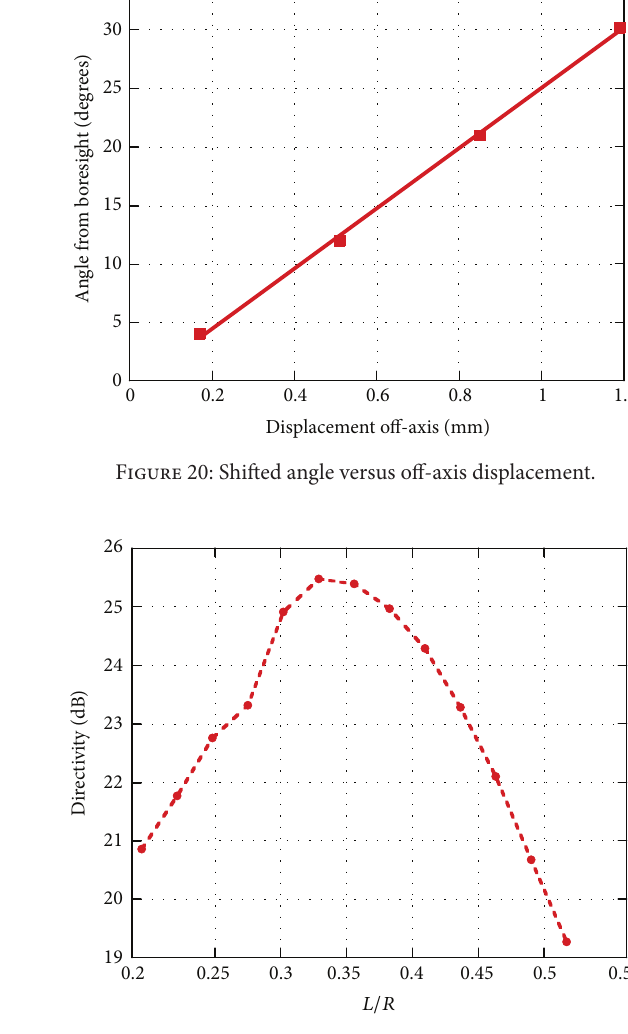
Figure 21: Directivity of hyperhemispherical lens as a function of 𝐿/𝑅 at 300